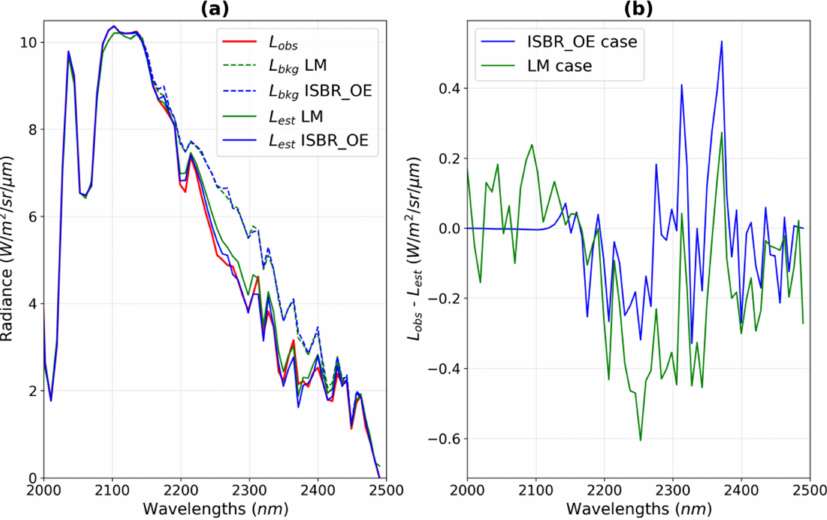
Figure 5. ( a ) Observed radiance (red) and background radiances (dashed lines) for linear (green) and hybrid (blue) methods, estimated radiances (solid lines) with LM (green) and ISBR-OEM (blue) retrieved concentrations. ( b ) Difference between observed and estimated radiances for both cases.